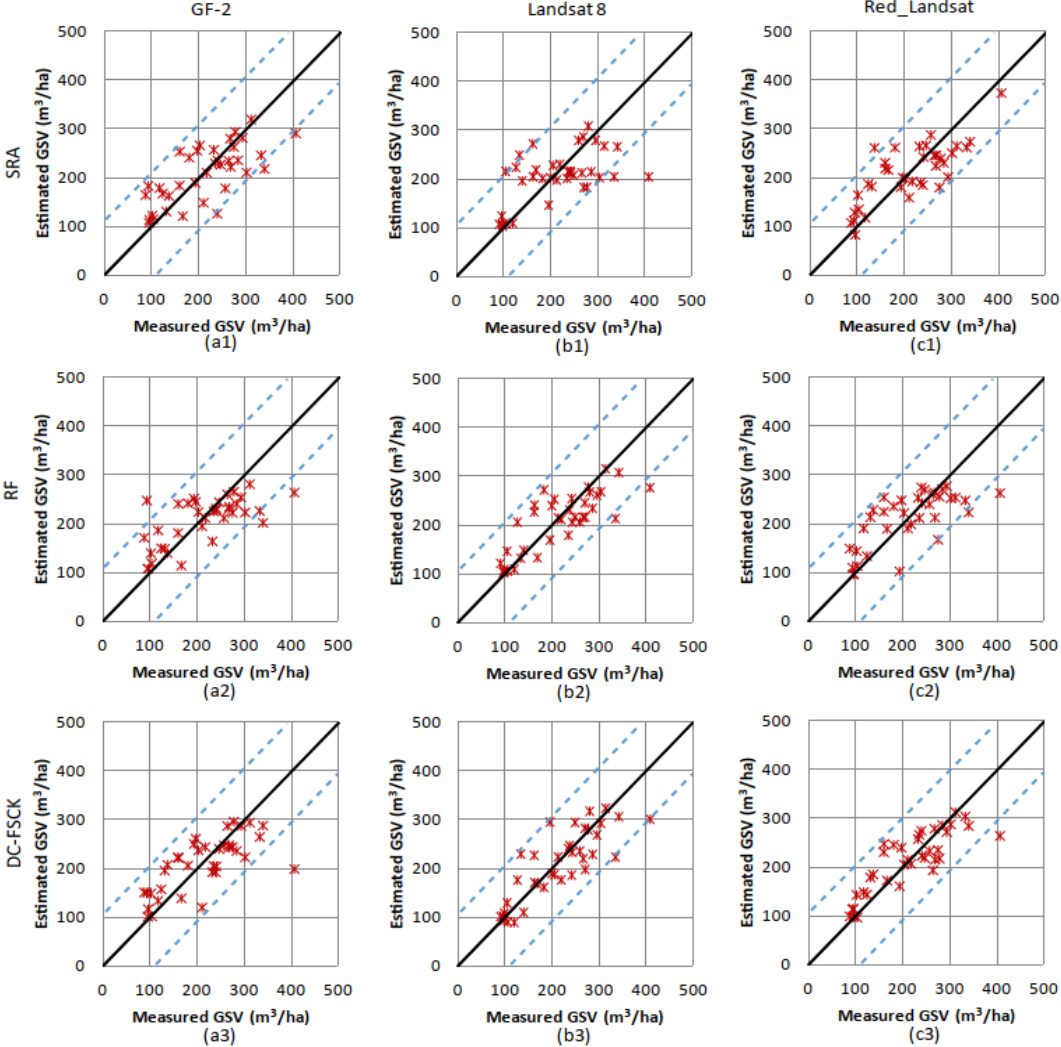
Figure 4. The scatter graphs between the observed and estimated GSV values of the larch plots using three dataset and three variable screening methods (SRA, RF, and DC-FSCK): ( a , b , c ) are the GSV estimated by the GF-2, Landsat 8, and Fusion image Red_Landsat, respectively; ( 1 , 2 , 3 ) are the GSV estimated using three variable screening methods SRA, RF, and DC-FSCK, respectively. Each graph corresponds to the best estimation model with the smallest RMSEr value for each data scenario in Table 6. The black diagonal line is the theoretical best fit reference line, and the blue parallel dashed lines are the estimation residual reference lines with a 50% deviation from the sample mean.